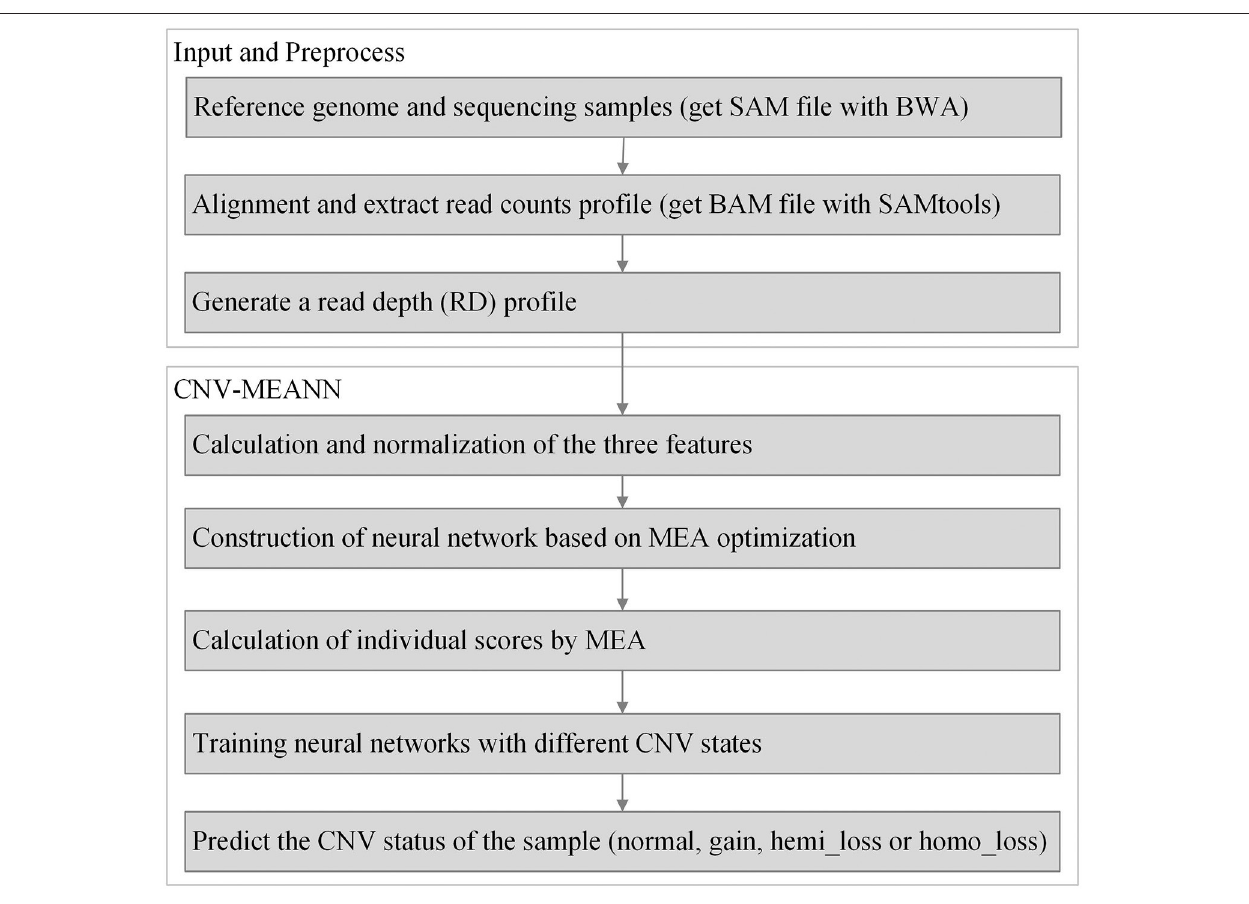
FIGURE 1 | Workflow of the CNV-MEANN method for the detection of CNVs from NGS